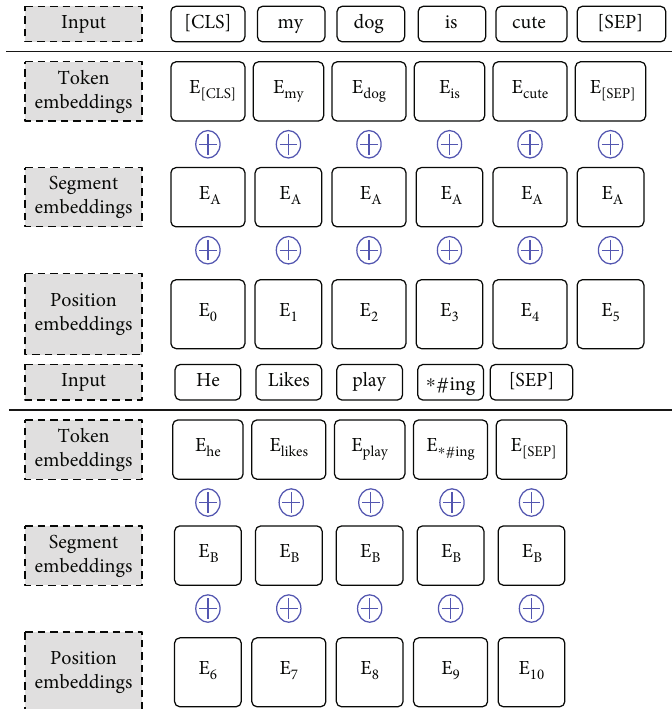
Figure 3: Composition of input vectors of the Bert model.